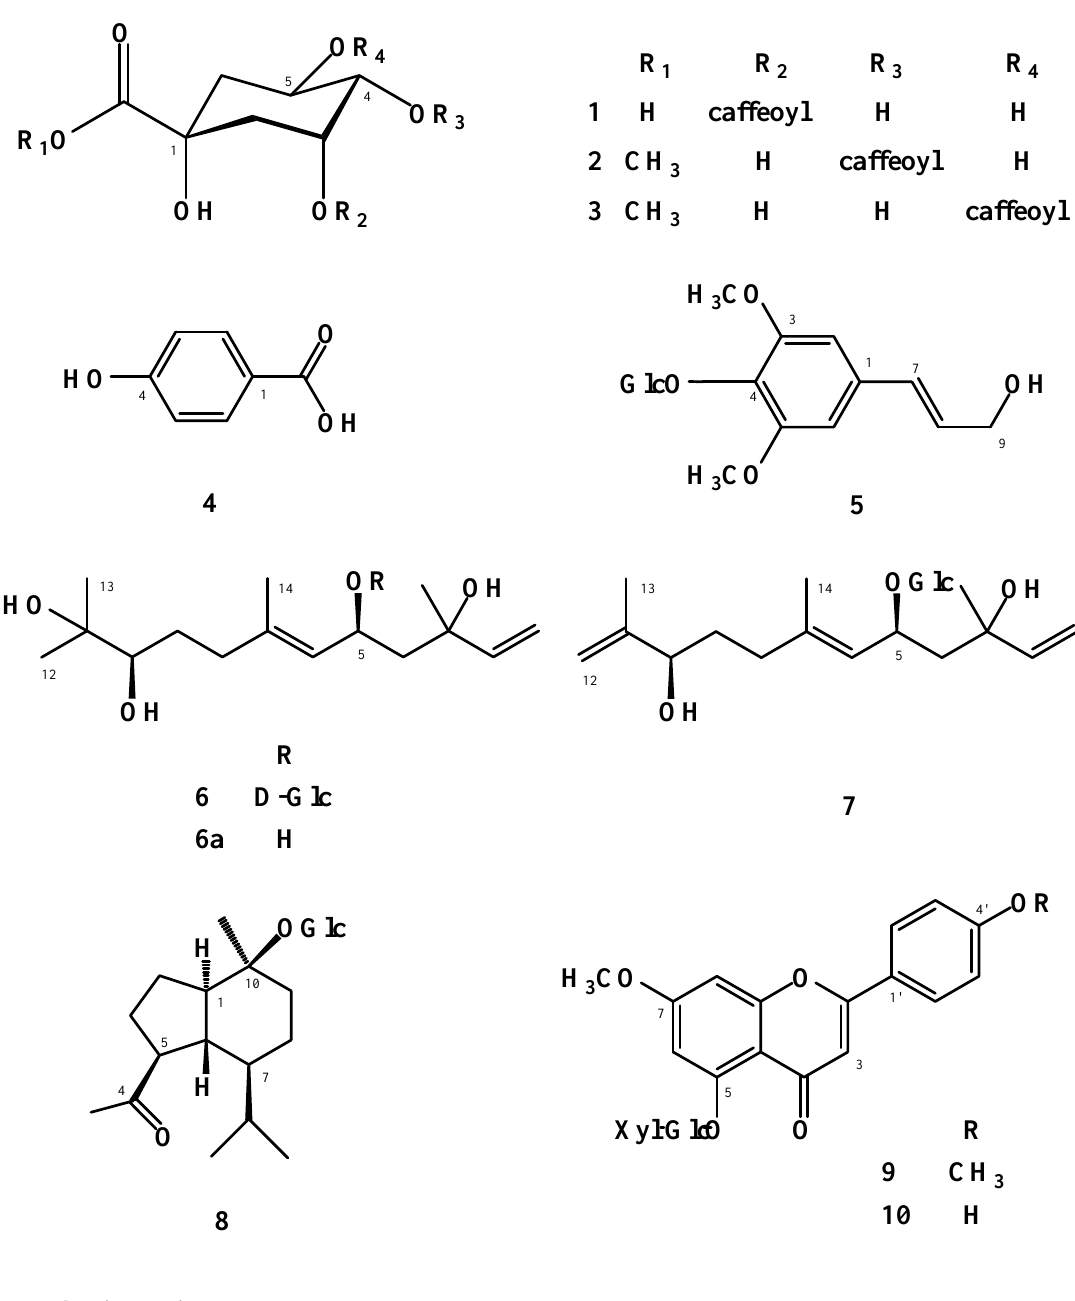
Figure 1. The structures of compounds 1 - 10